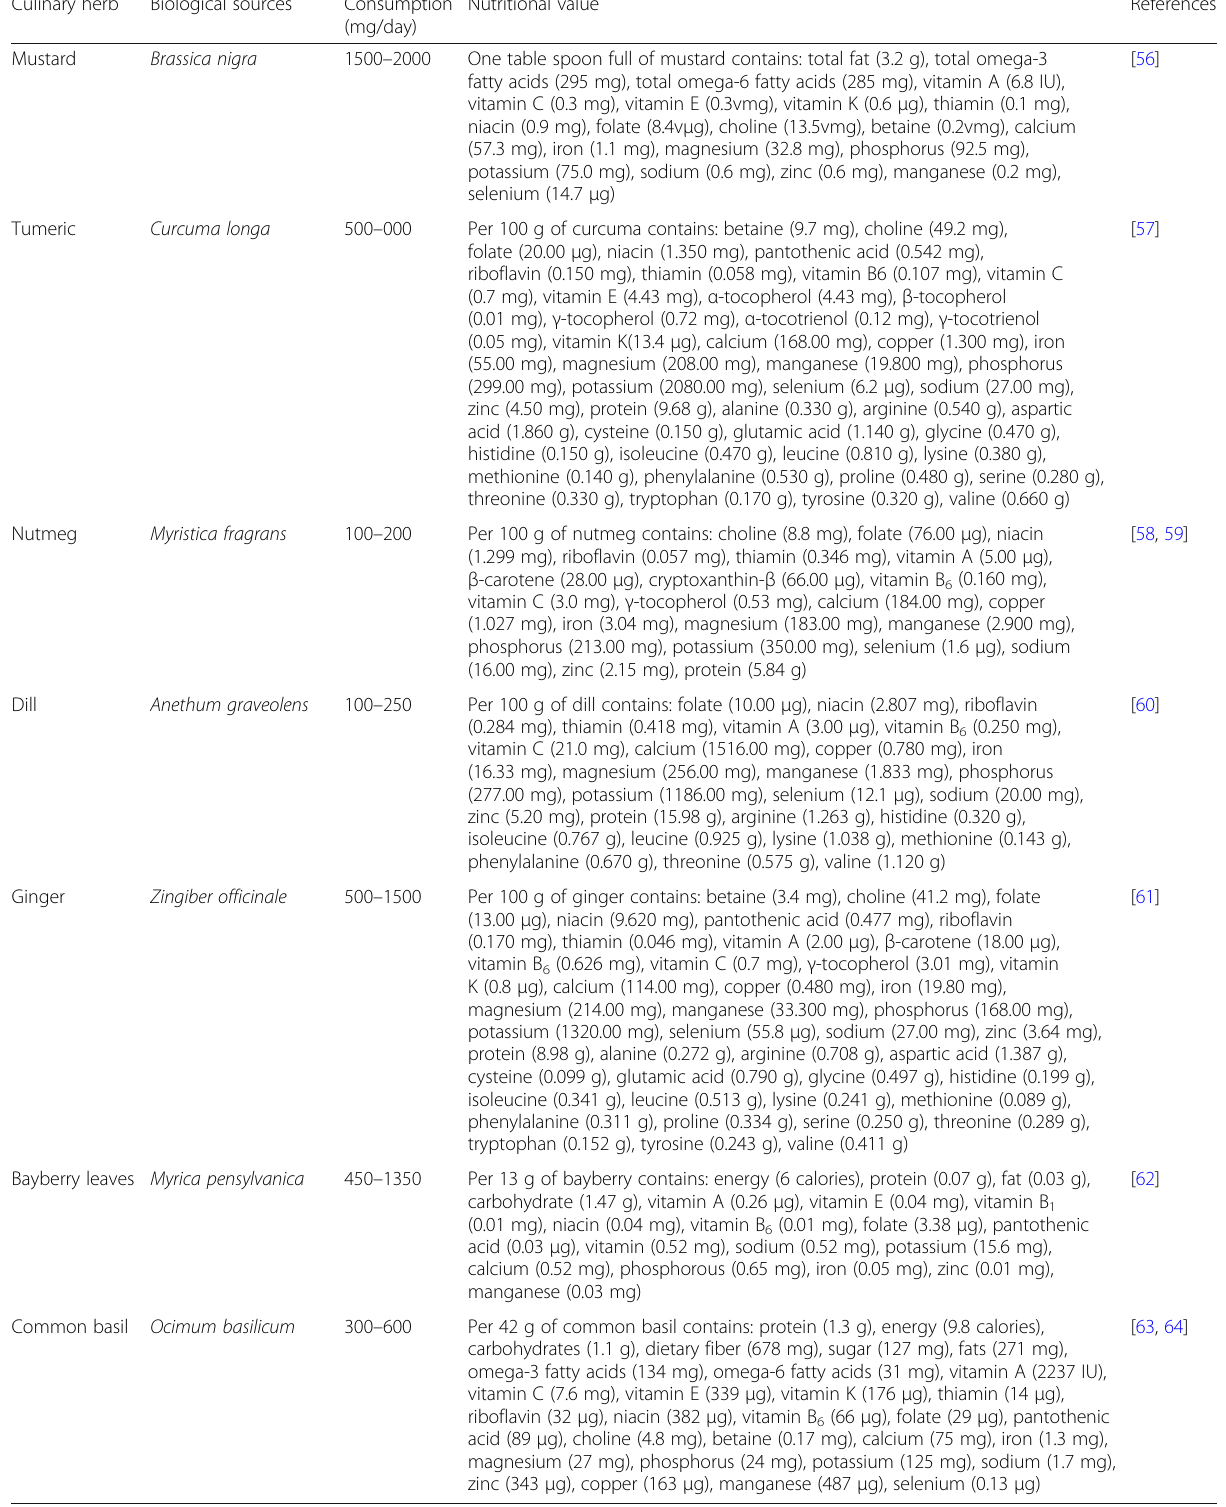
Table 2 Culinary herbs and spices in daily use (Continued)